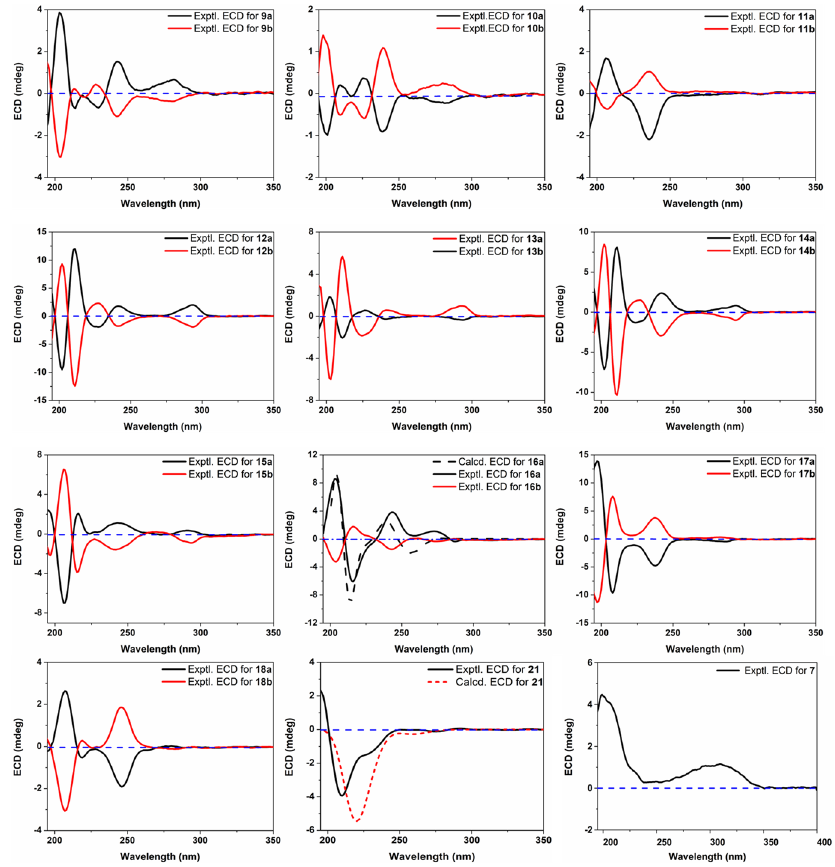
Figure 3. Experimental and calculated ECD spectra for 7 , 9 – 18 , and 21